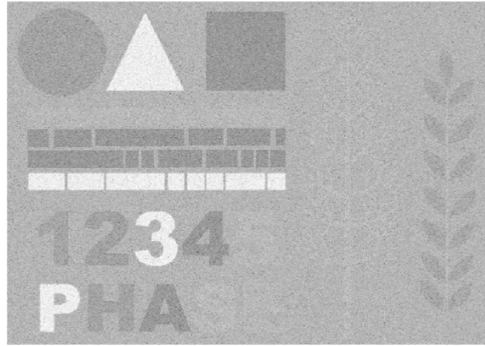
Figure 6. Mean amplitude of the simulated SLC data stack.